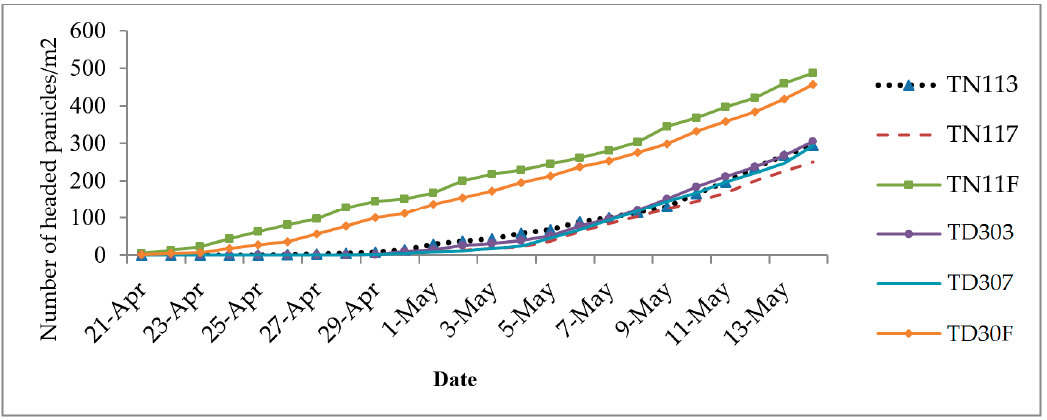
Figure 3. Daily headed panicle number produced by different irrigation regimes.